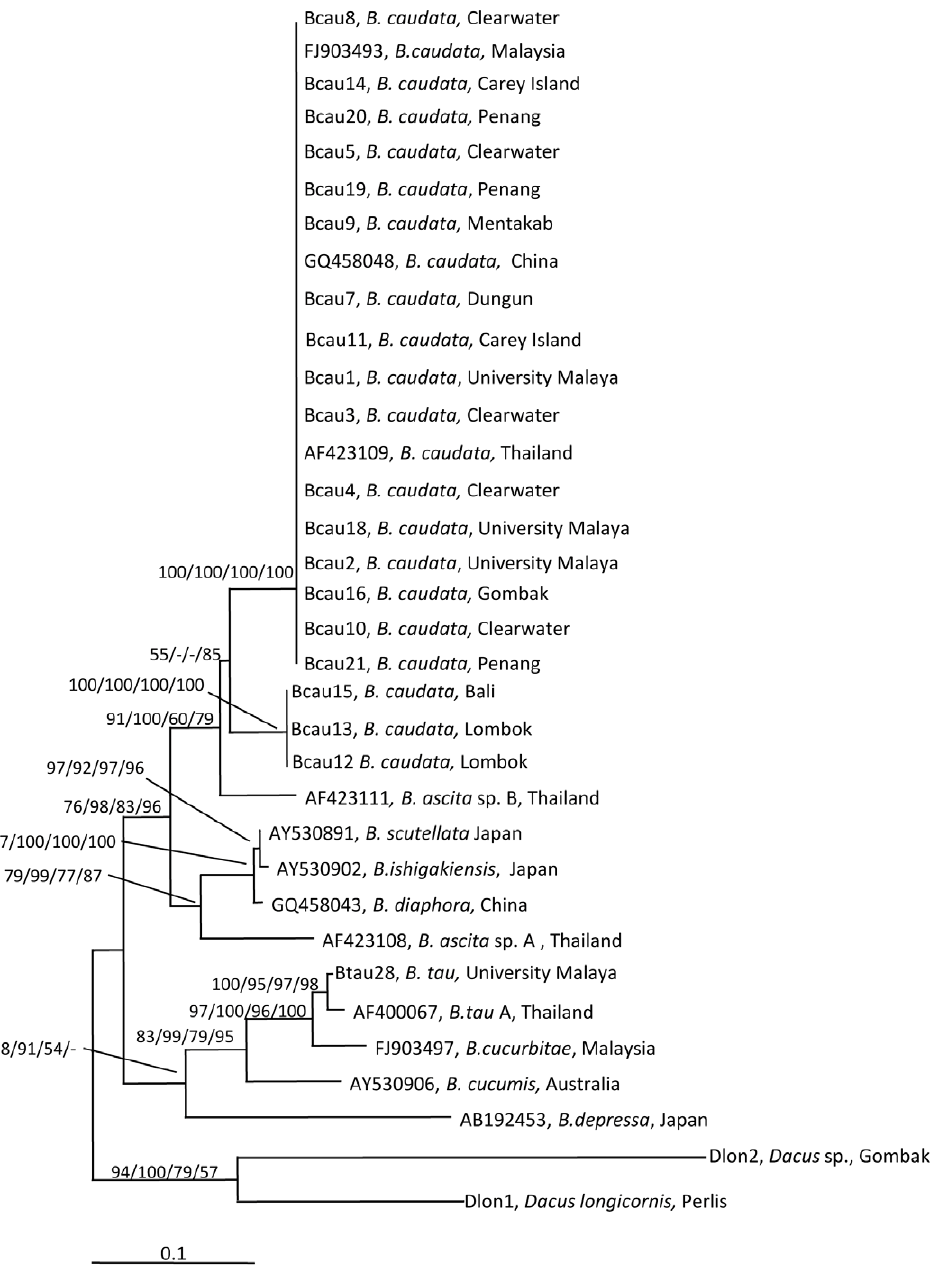
only. This group is further divided into two main clades: (1) B.